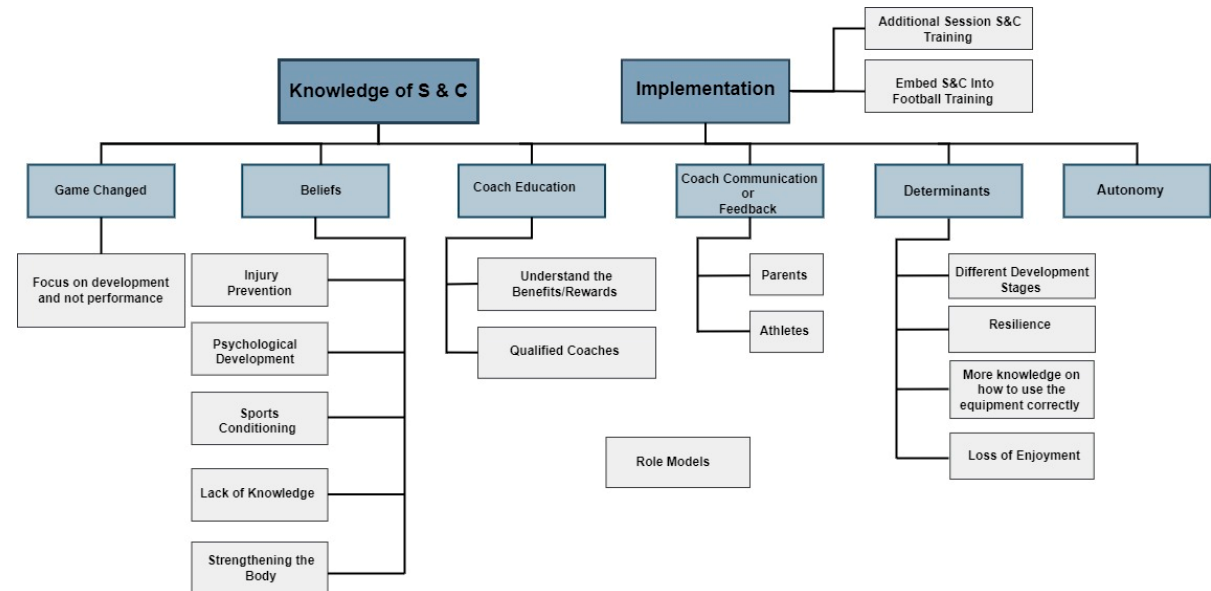
Figure A1. Coding tree for themes and subthemes arising from the focus group interviews.